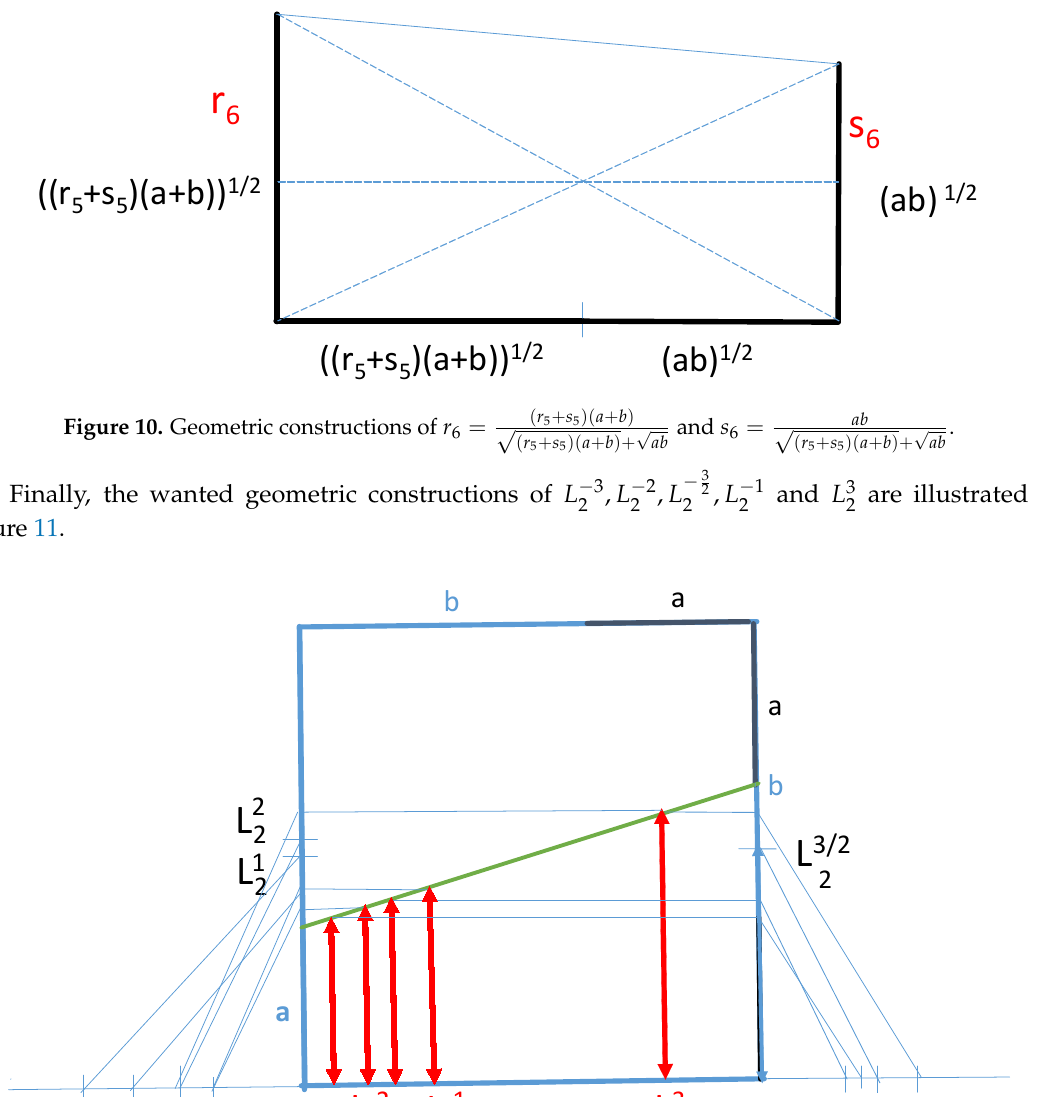
− 3 2 , L − 2 , L , L − 1 and L 3 2 2 2 2 2 3 2 ; L ; L (cid:0) and L 3 (cid:0) (cid:0) 2 2